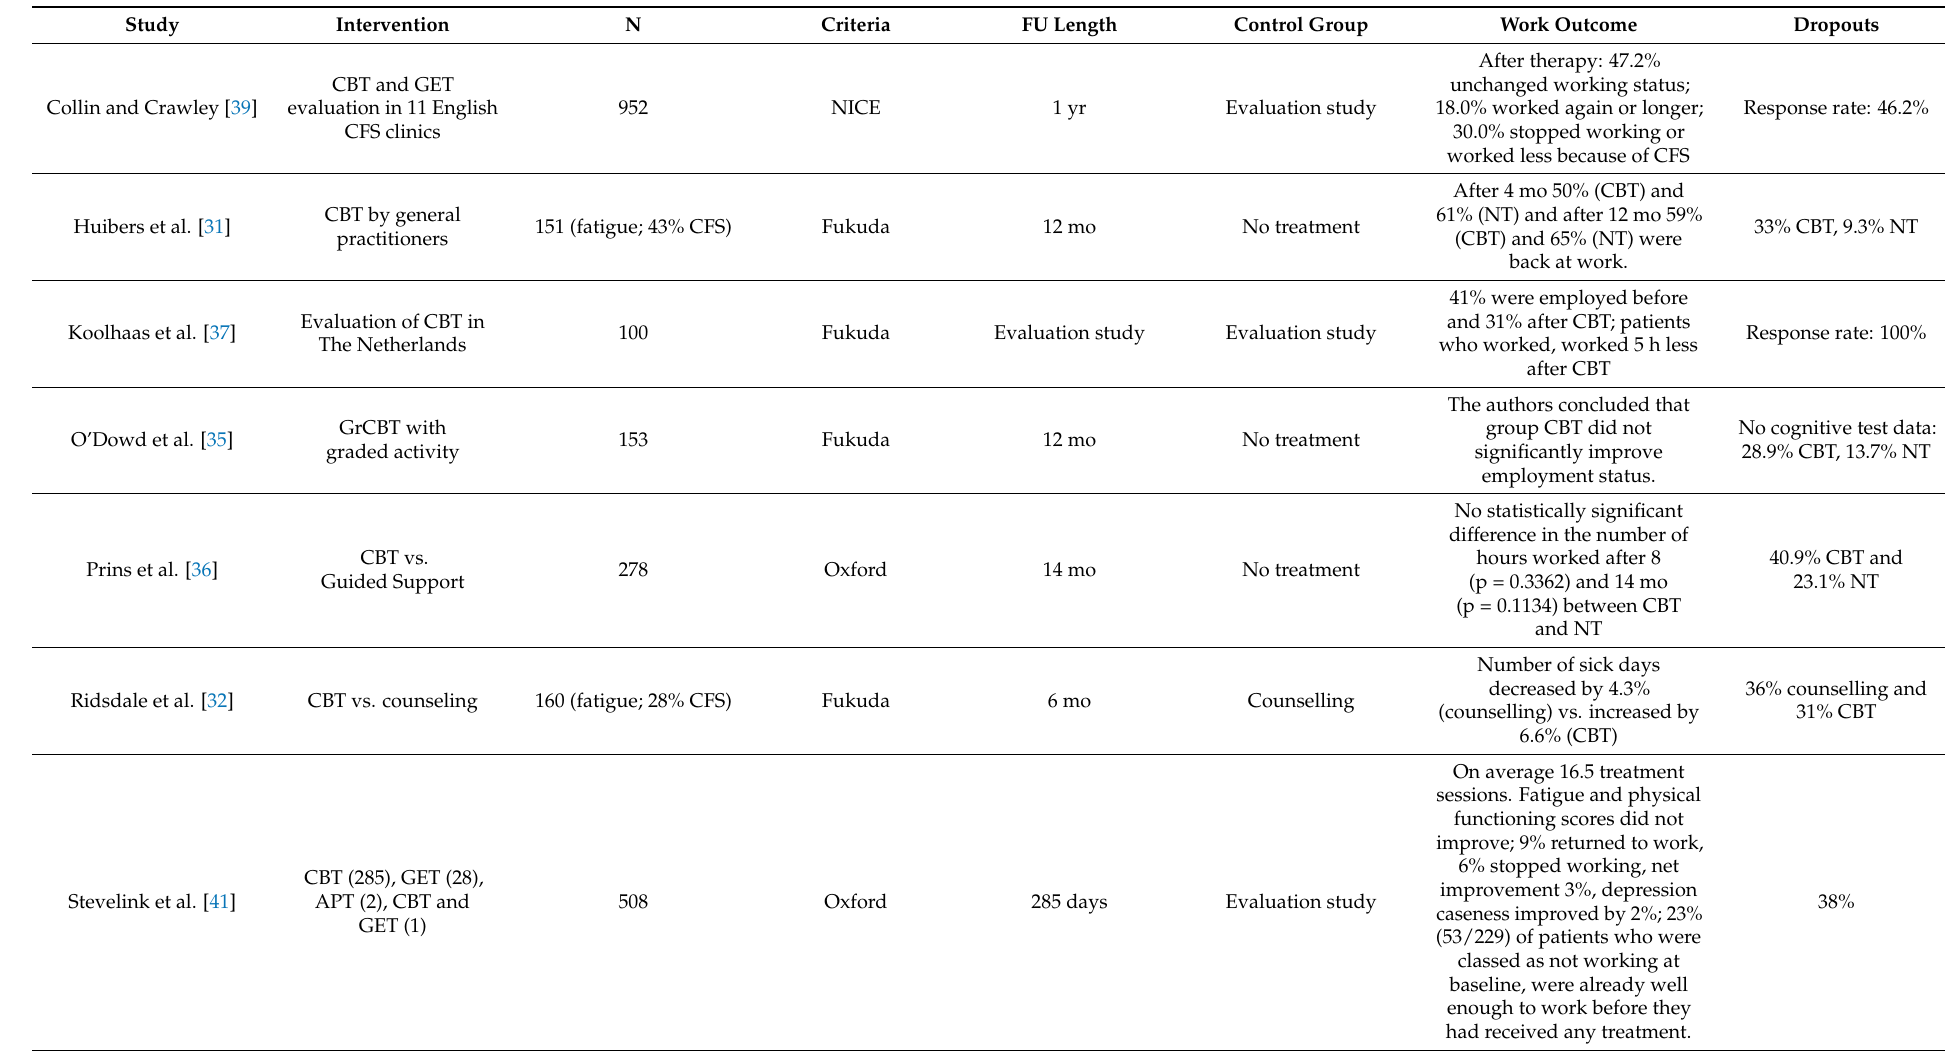
Table 1. Work status before and after treatment with CBT and/or